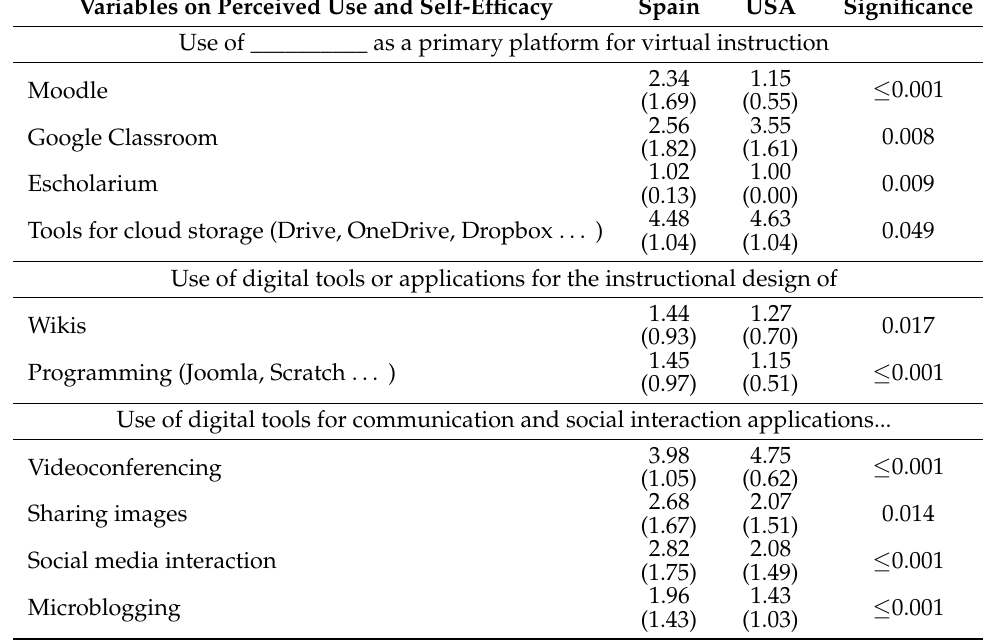
Table 2. Student’s t -test accounting for the country of origin. Variables on Perceived Use and Self-Efficacy